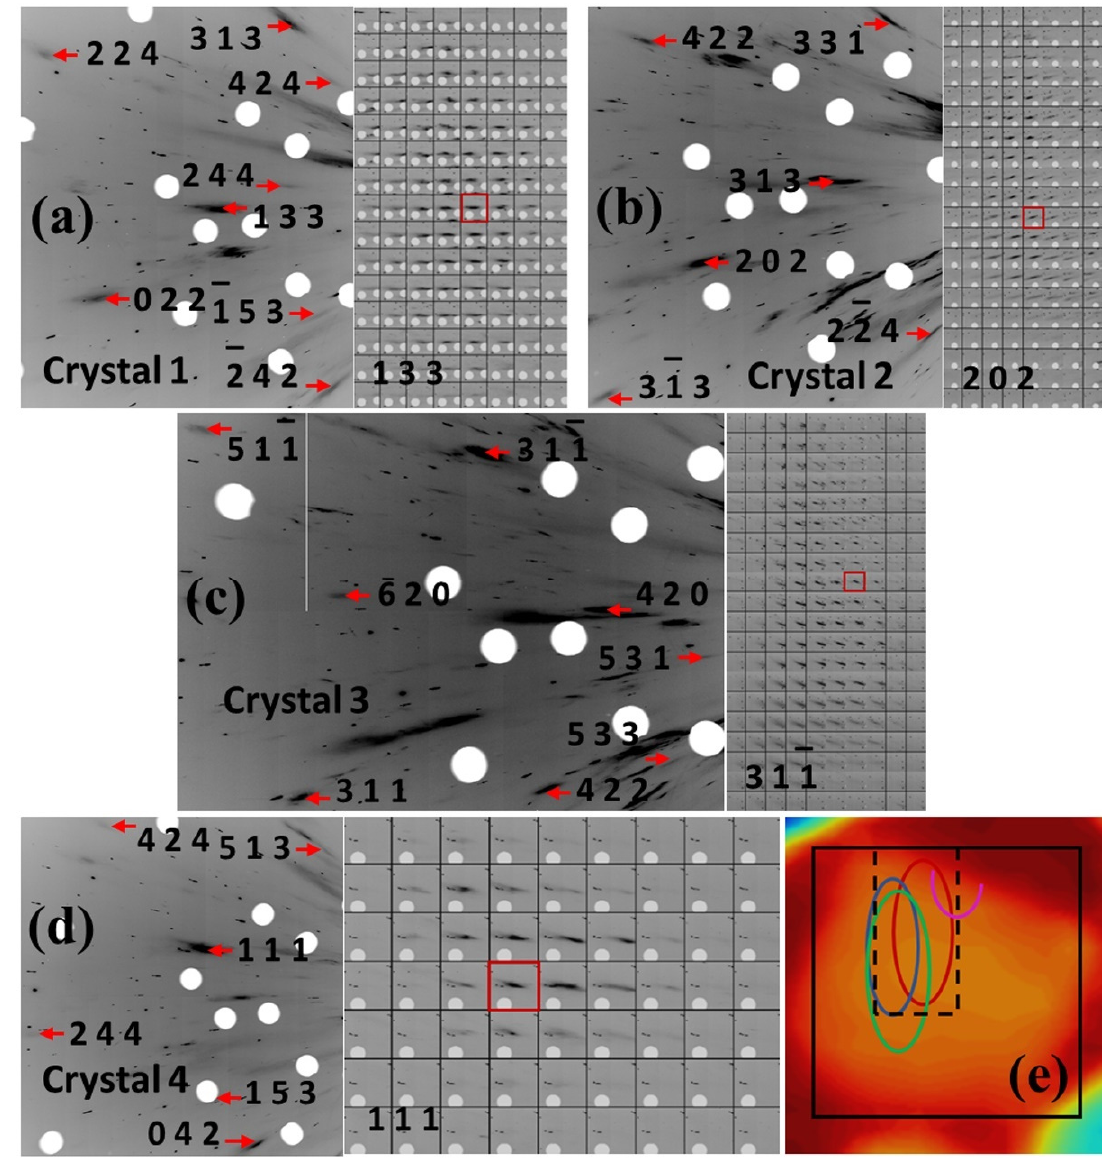
Figure 5. ( a – d ) Laue diffraction patterns (left) and maps of respective reflections (right) from crystals 1–4 obtained at 5.3 GPa. Red rectangles denote the position where diffraction patterns were collected. ( e ) Encircled areas of crystals 1 (red), 2 (blue), 3 (green) and 4 (magenta). Black rectangle denotes the Laue diffraction scan area, and dotted line outlines the local scan area—which is explained further in the text.